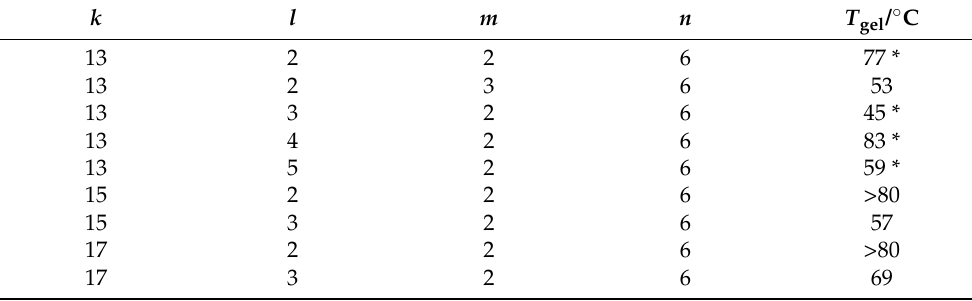
Table 1. Relationship between the chemical structure of AAO and T gel